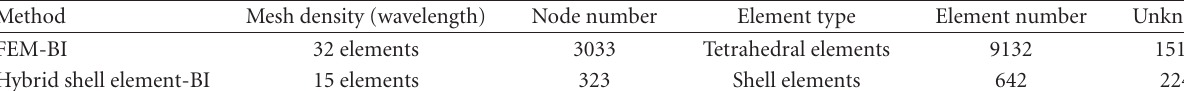
Table 1: The comparison of the FEM-BI and the hybrid shell element-BI. Bistatic RCS of the conducting sphere coated by magnetic material is calculated.